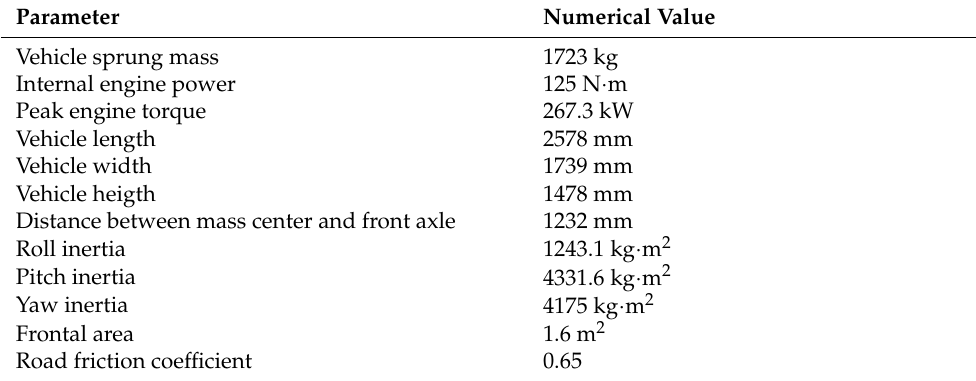
Table 1. Main parameters configuration of the vehicle